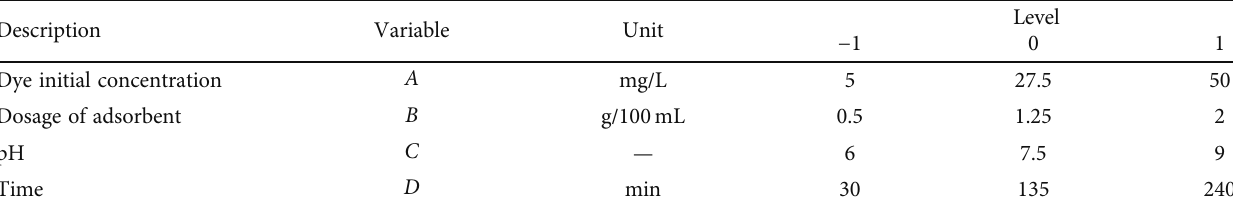
Table 1: Levels of the four variables of adsorption